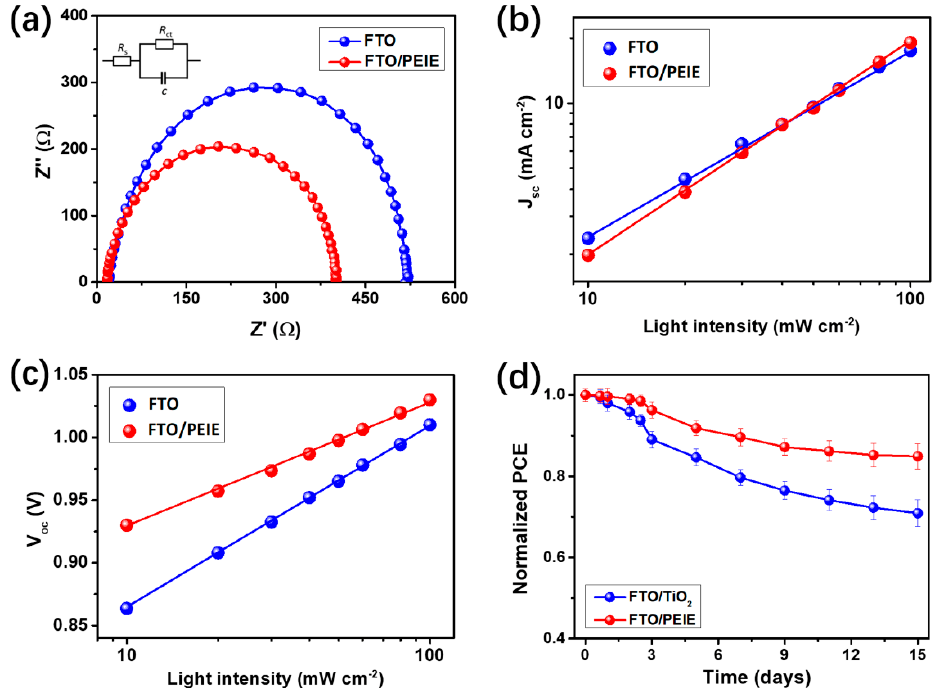
Figure 6. ( a ) EIS spectra of the PSCs fabricated on bare FTO and FTO/PEIE substrates; Light inten- sity dependence of J sc ( b ) and V oc ( c ) for PSCs using bare FTO and FTO/PEIE as the cathodes ( d ) Long-term stability performance of the PSCs fabricated on FTO/PEIE and FTO/TiO 2 substrates, in terms of the normalized PCE vs.